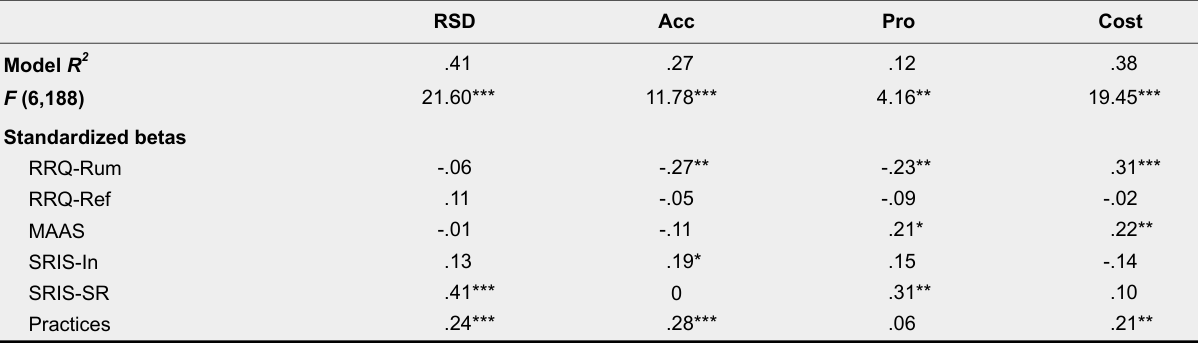
Predictors of Self-Awareness Outcomes (SAOQ Subscales): Regression